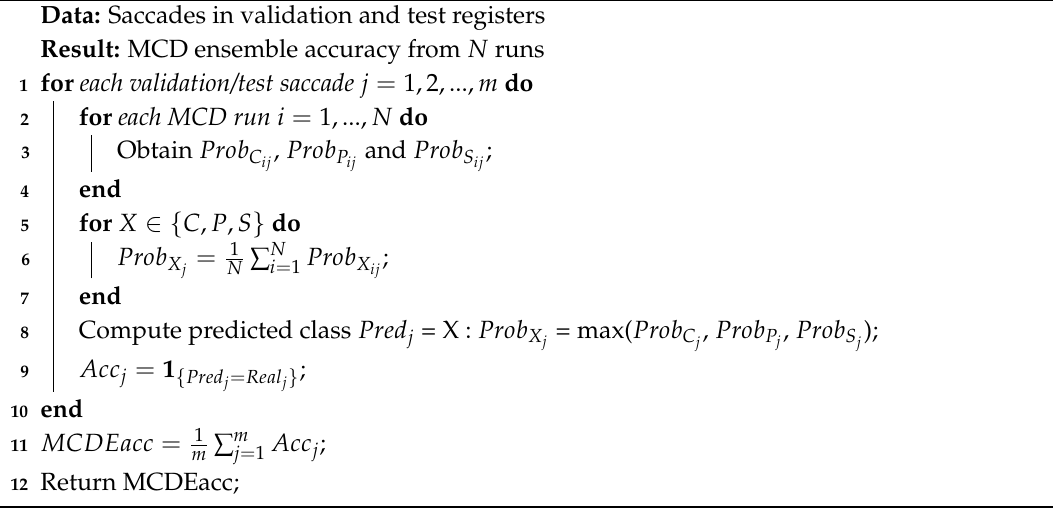
Algorithm 2: MCD ensemble (MCDE) calculation of class probabilities and labeling for individual saccades and computation of accuracy. This procedure is applied to both validation and test registers with constituent